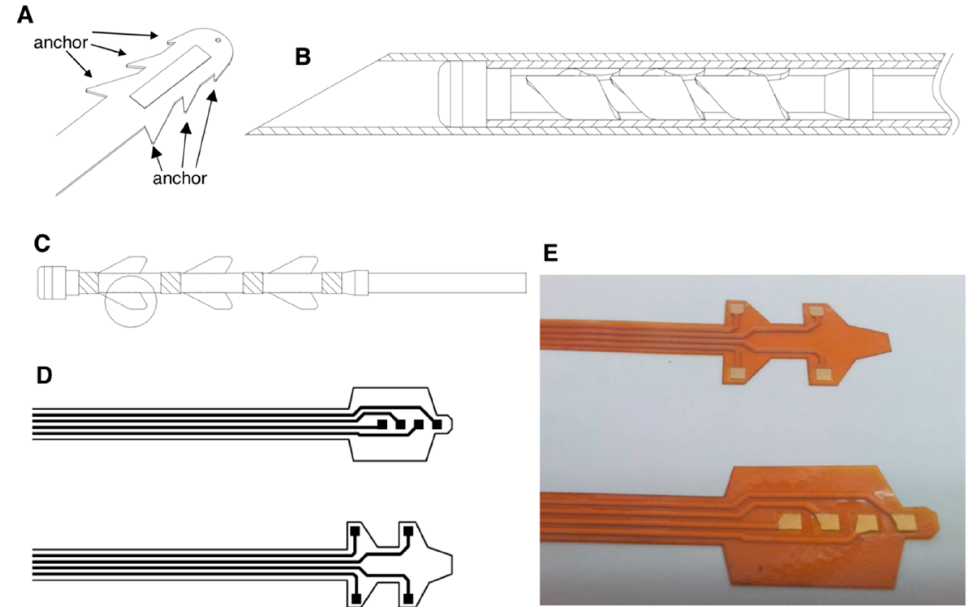
Figure 4. Designs of the neuron stimulatory electrodes. ( A ) The stretchable electrode is designed with fixing anchors on the edge. ( B ) Illustration of the guiding needle for the delivery of a stretchable electrode. ( C ) Expanded electrode with fixing anchors. ( D ) Deployment of an electrode on the stretchable matrix. ( E ) Two prototypes of stretchable electrodes made by polyimide.